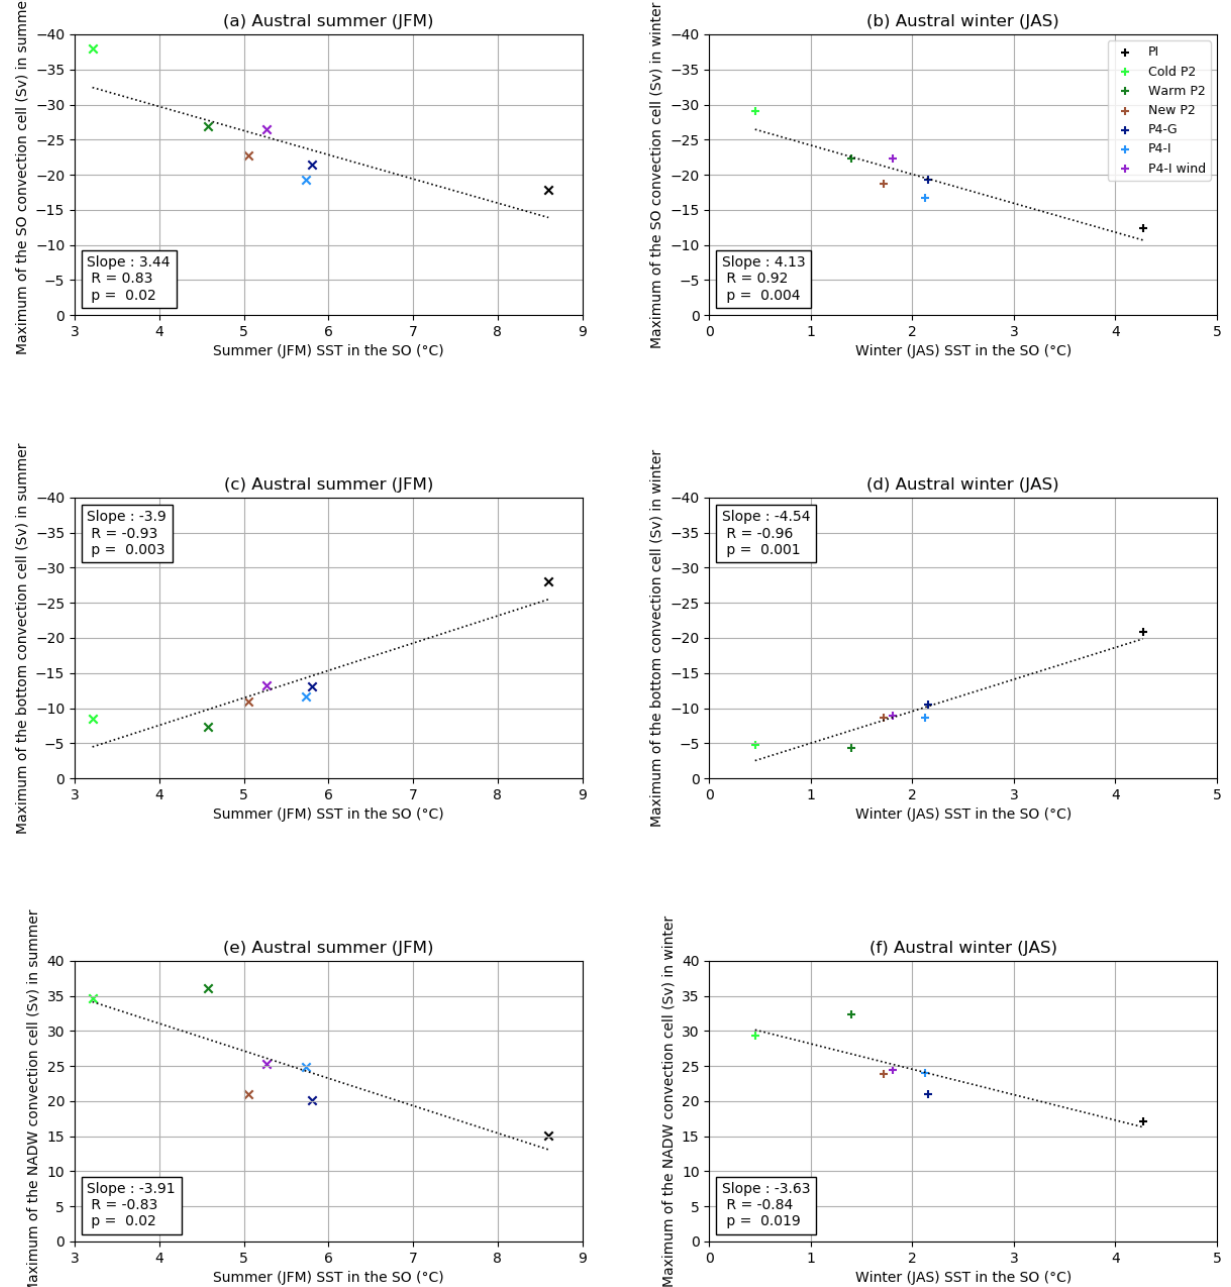
Figure 8. Relationships between the mean SST in the Southern Ocean (averaged up to 36 ◦ S) and the Southern Ocean (a, b) , bottom (c, d) , or NADW (e, f) overturning cell maximum, for all simulations except “P4-I brines” and “P4-I hosing”. The y axis is inverted for the two counterclockwise cells (a–d) . The dotted line represents the linear fit to the model results plotted